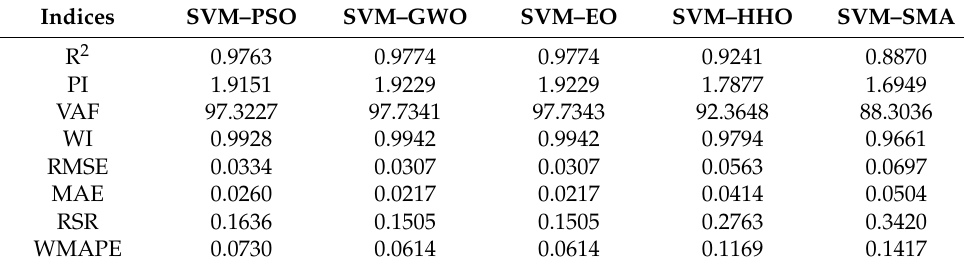
Table 6. Performance indices for the training dataset.